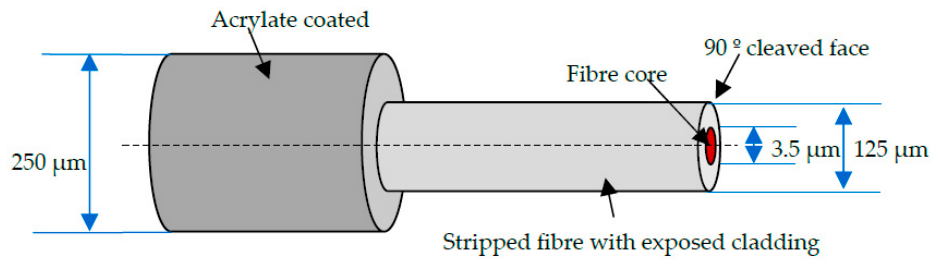
Figure 1. A schematic illustration of an optical fibre used as an alternative to piezoelectric sensors for structural health monitoring.